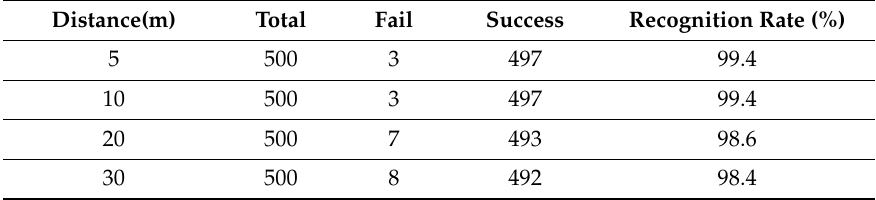
Table 8. Test result of recognition